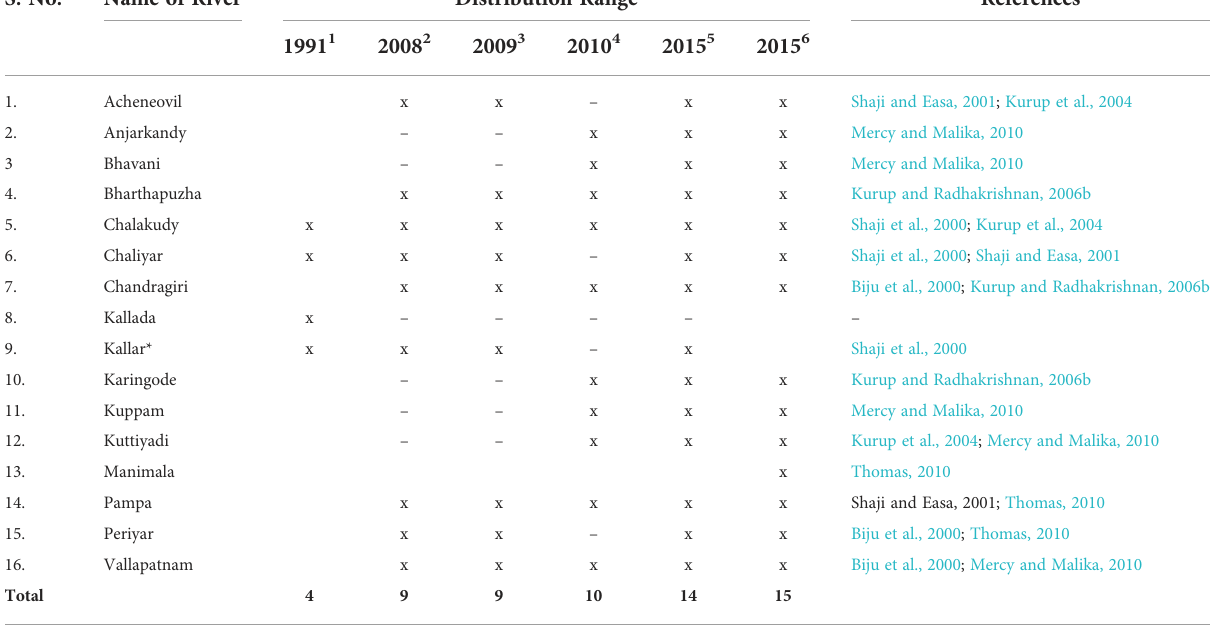
TABLE 1 The rivers of the Western Ghats, India, with the presence of P. denisonii . S.